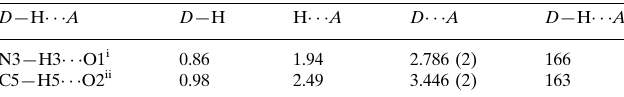
Hydrogen-bond geometry (A˚ , (cid:2)